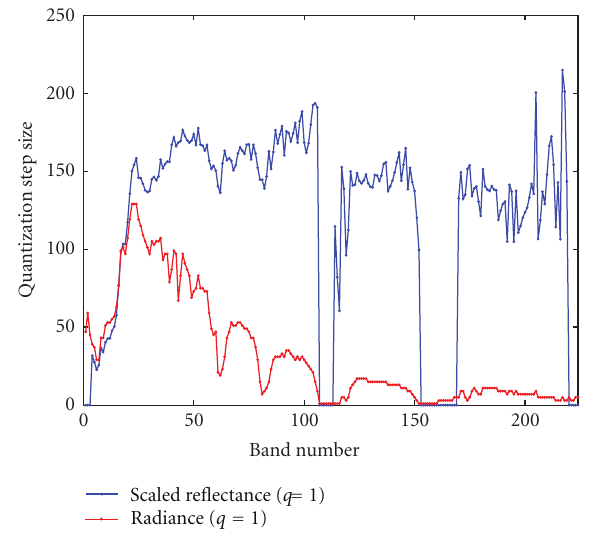
Figure 6: Quantization step sizes for virtually lossless compression of radiance data and their extrapolation to reflectance spectra, whose values have been rescaled in the same range.